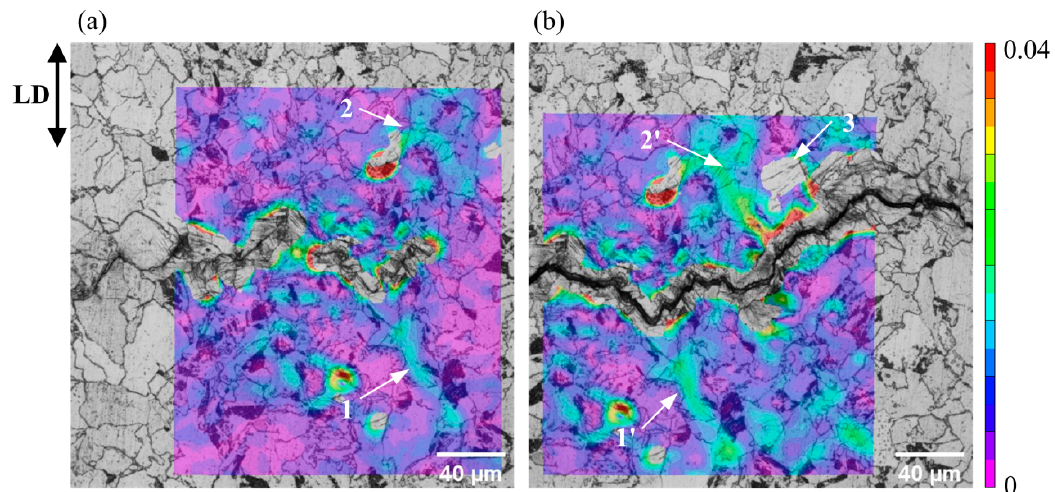
Figure 9. Von Mises strain fields of the LD1 specimen under 50 × objective lens: ( a ) a = 1.2 mm, Figure 9. von Mises strain fields of the LD1 specimen under 50× objective lens: ( a ) a = 1.2 mm, N = N = 80,000 cycles; ( b ) a = 1.75 mm, N = 95,000 80,000 cycles; ( b ) a = 1.75 mm, N = 95,000 cycles.